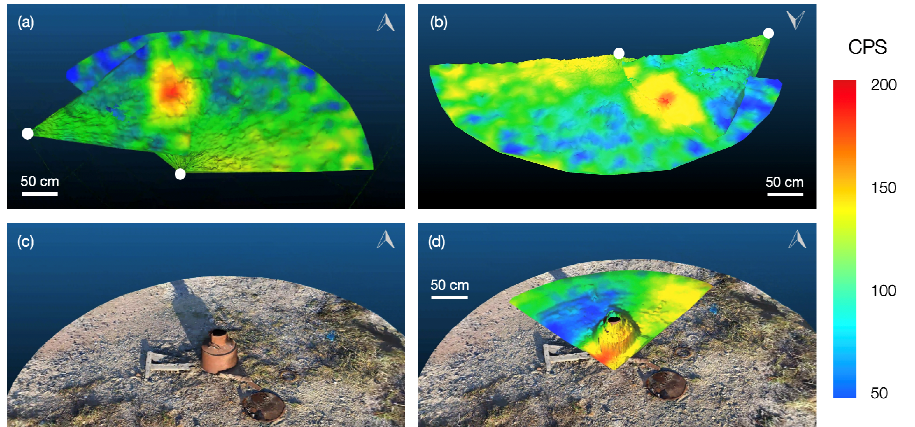
Figure 8. ( a ) and ( b ) overlain radiation intensity scans (CPS) obtained from two perspectives by the CC-RIAS system (position of scanning device indicated by white dots), ( c ) 3-dimensional photogram- metry reconstruction of an object of interest, and ( d ) the 3D photo-realistic rendering overlain with the point-cloud data captured by the CC-RIAS